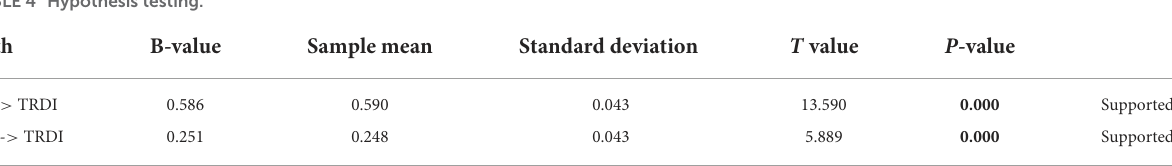
TABLE 4 Hypothesis